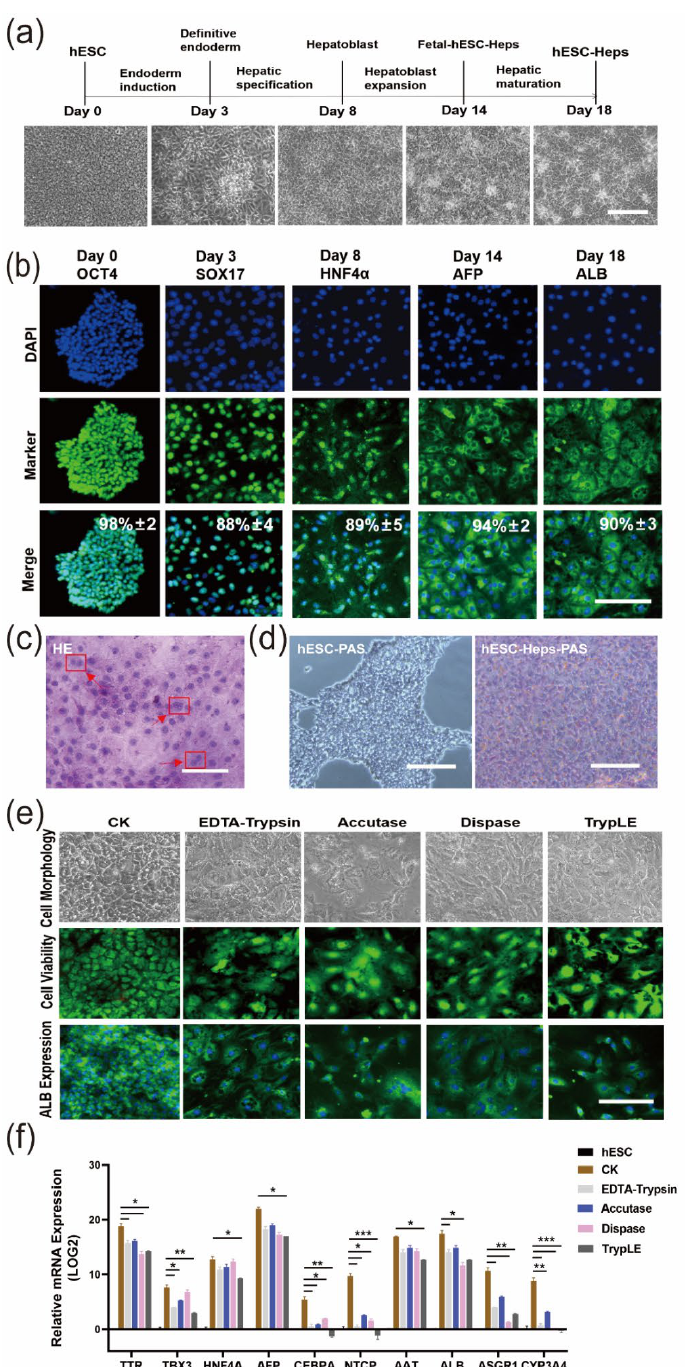
Figure 1. Enzyme digestion reduces the maturity of hESC-Heps differentiation. ( a ) Cell morphologies (bright field images) during differentiation of hESCs into hepatocyte-like cells in 2D monolayer culture (scale, 100 µ m). ( b ) Expression of Oct4, SOX17, HNF4a, AFP, and ALB on Days 0, 3, 8, 14, and 18, imaged using fluorescence microscopy ( n = 5 random regions) (scale, 50 µ m). ( c ) HE stain showing double nuclei of differentiated hESC-Heps (scale, 100 µ m). ( d ) Glycogen storage in hESC and hESC-Heps, as indicated by PAS staining (scale, 100 µ m). ( e ) Effects of digestive enzymes on cell morphology, cell activity, and albumin expression after hESC-Hep digestion (scale, 100 µ m). ( f ) Comparison of the mRNA expression levels of stage-specific genes in the digested and undigested hESC-Heps (scale, 100 µ m). Data are the mean ± SD ( n = 3) and analyzed by Student’s t test. * p < 0.05, ** p < 0.01, *** p <